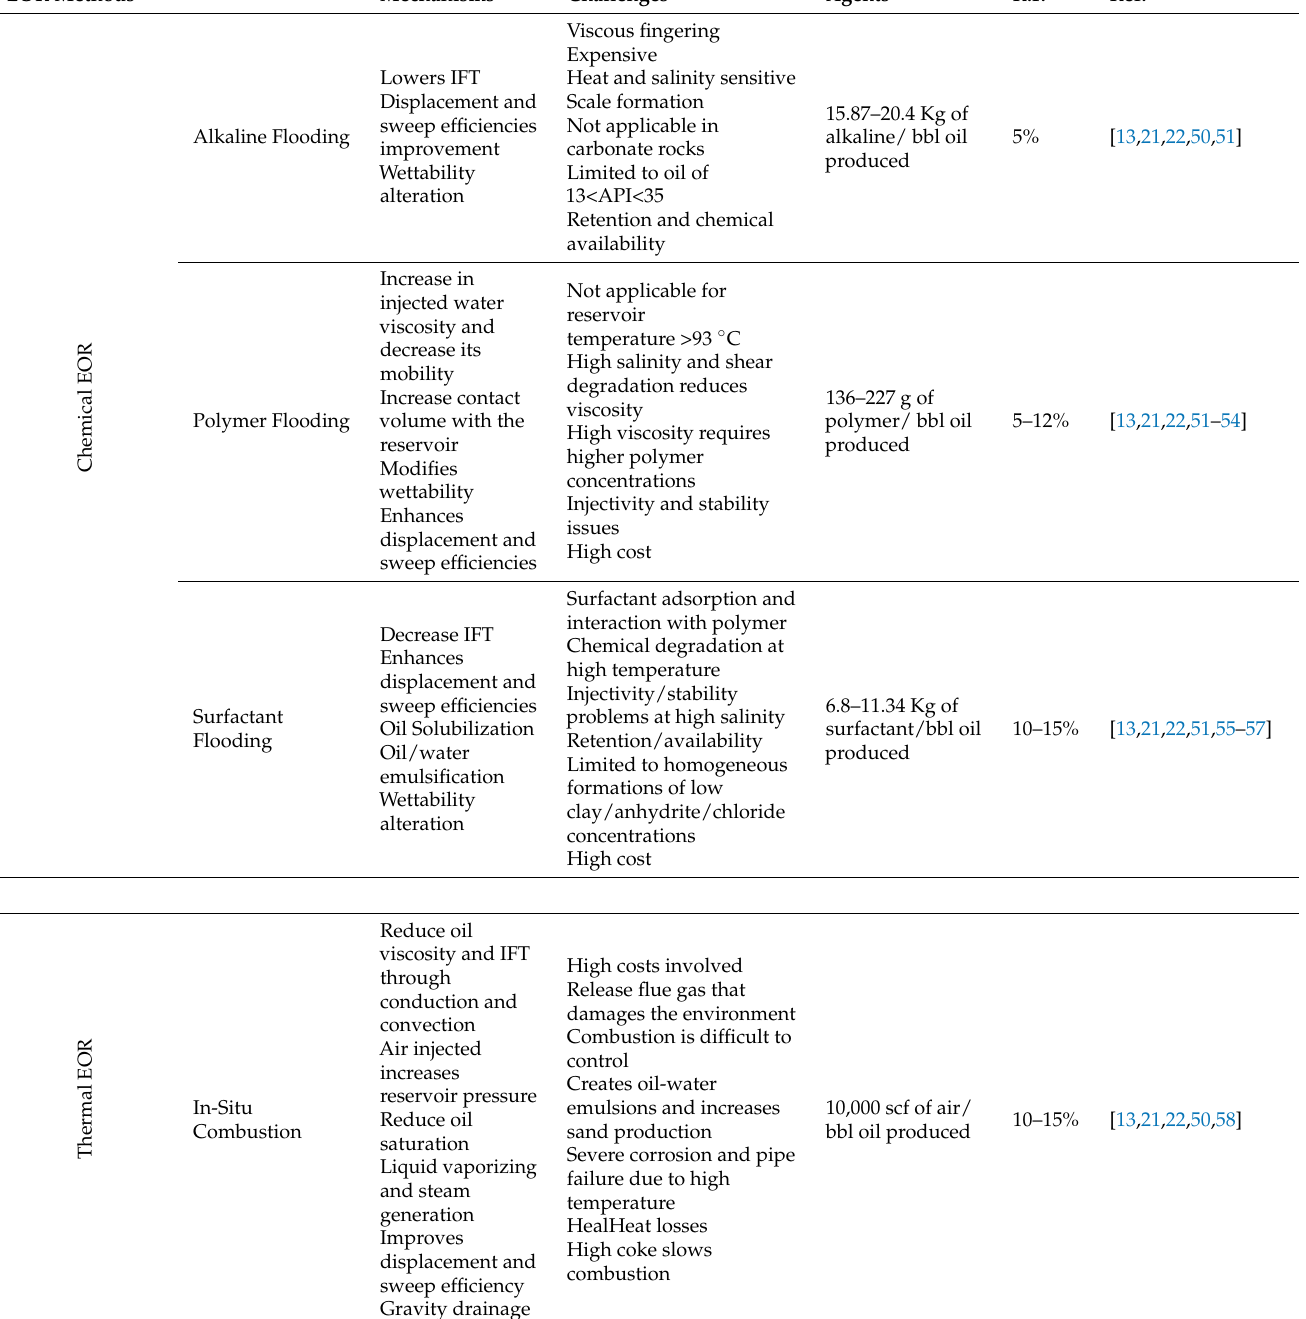
Table 1. Classification of EOR methods with their respective mechanisms, challenges, limitations, agents utilized, and expected recovery rates, without including